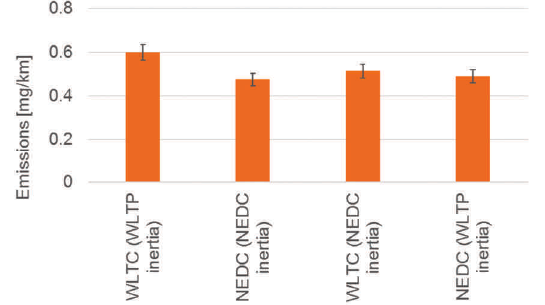
Fig. 13. PM emissions from vehicle 4 for the various test types performed